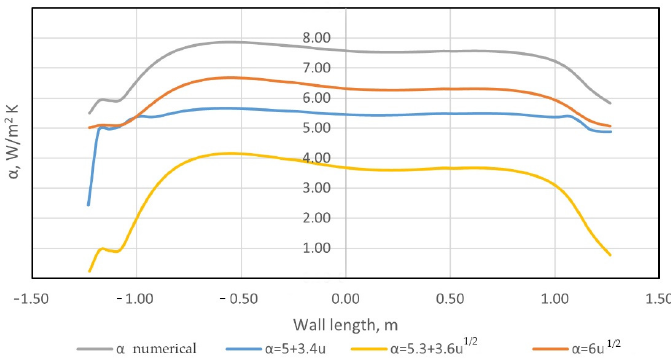
Figure 19. Heat transfer coefficients for the left wall α out .